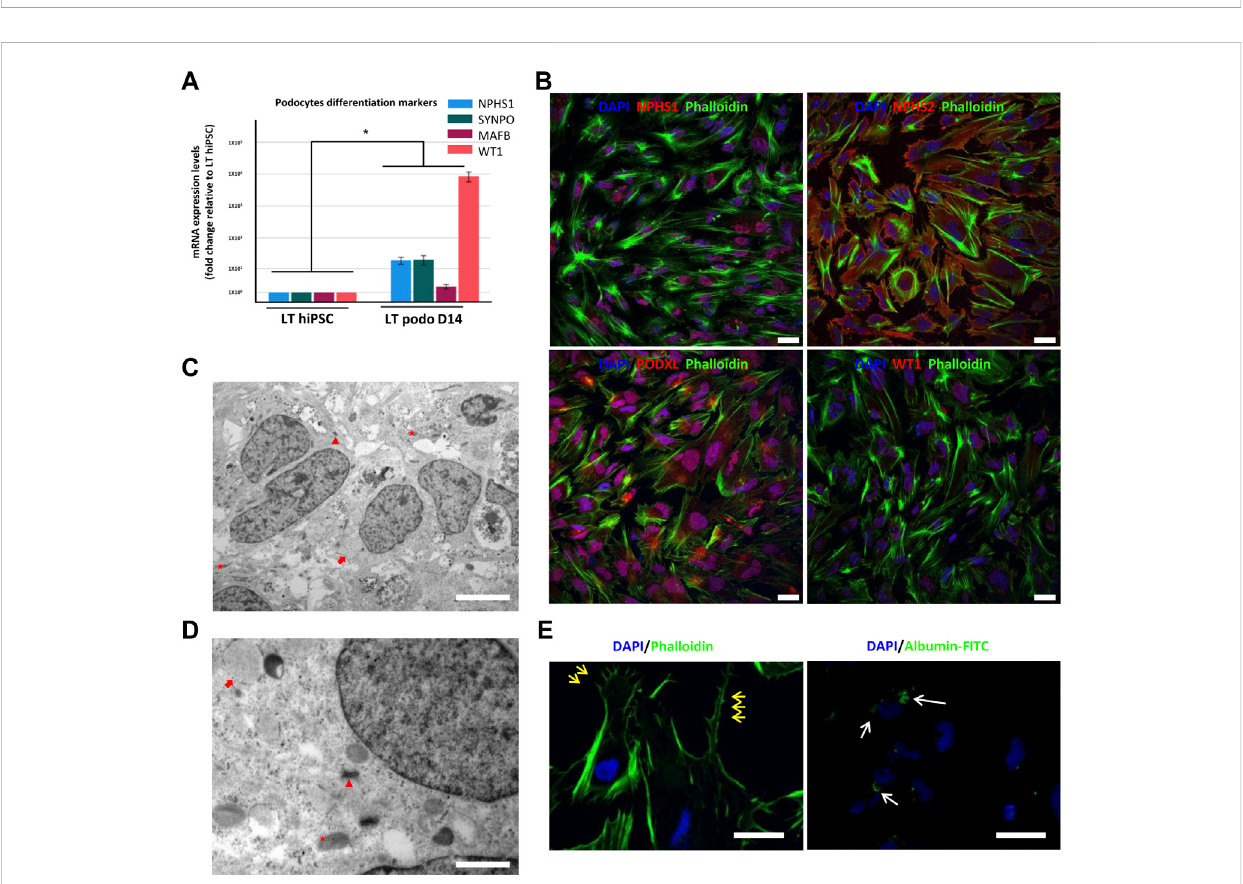
FIGURE 2 CharacterizationofhiPSC-derivedpodocytes.hiPSCsdifferentiated for14 days usingourinduction protocol generatepodocytesexpressingmRNA of the podocyte markers NPHS1, SYNPO, MAFB, and WT1 (A) . In (B) , immuno fl uorescence of NPHS2 (podocin), NPHS1 (nephrin) and WT1 in LT hiPSC- derived D14 podocytes. Scale bar 20 μ m. (C) and (D) are electron micrographs of day 14 podocytes highlighting the mitochondria (asterisk), well developed desmosomes (arrowhead) and developing RER (arrow), magni fi cation 5,000X, scale bar 2,000 nm (C) 200,00X, scale bar 500 nm (D) . In (E) ,primaryandsecondaryfootprocess(yellowarrows)evidencedbyphalloidinstaining,andontherightimageendocytosisofFITCconjugatedalbumin by LT day 14 podocytes. Scale bar 30 μ m. Signi fi cance was tested by an unpaired t -test. Asterisk denotes statistically signi fi cant differences compared to undifferentiated LT hiPSC,* p < 0.05, n =